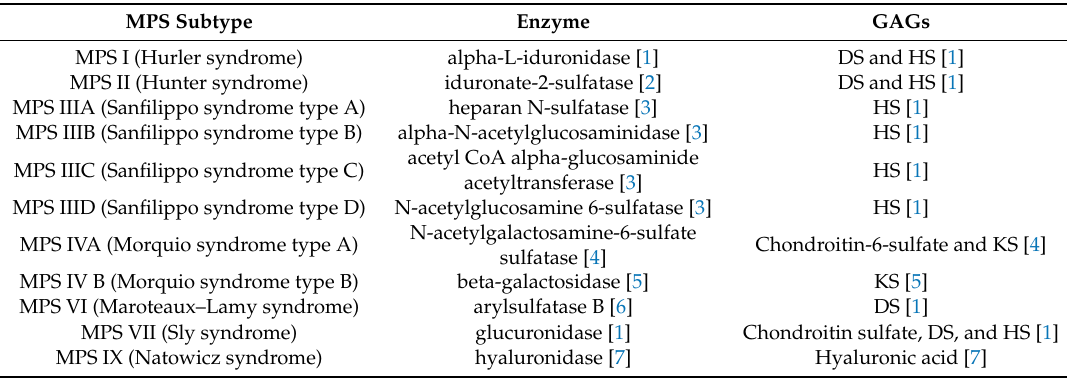
Table 1. Mucopolysaccharidoses (MPS) subtypes with enzyme deficiency and subsequent collection of glycosaminoglycans (GAGs).